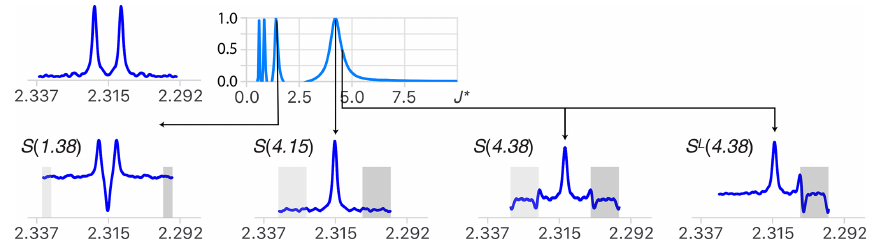
Figure 3. (Top right) Quality function of the deconvolution of an experimental doublet (top left). When starting with large values of J ∗ , the first extremum points to the largest coupling constant of the multiplet structure ( J ∗ = 4.15Hz). (Bottom) Structures obtained for decon- volution with J ∗ = 1.38 ( = J/ 3), 4.15 ( = J ) and 4.38 ( = J + 0 . 23)Hz and M L for 4.38Hz. When J ∗ (cid:54)= J , the presence of deconvolution artifacts (in the grey area) breaks the symmetry of the structure and causes a drop in the quality function except when J ∗ = J/ (2 n + 1), where n ∈ N ∗ . (See text for more details.)